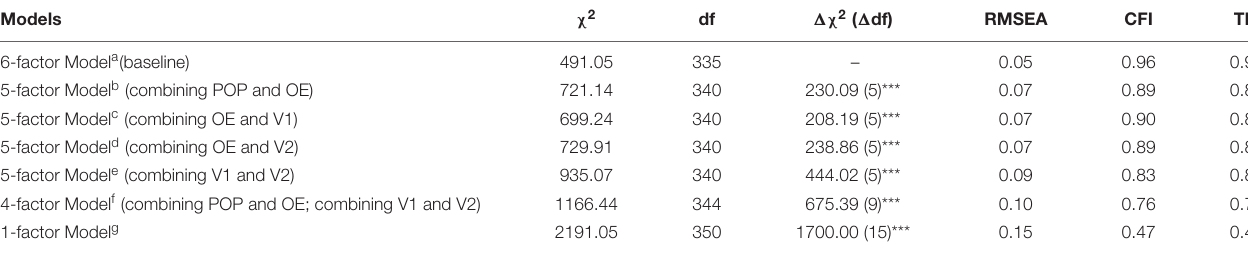
TABLE 1 | Results of confirmatory factor analysis.